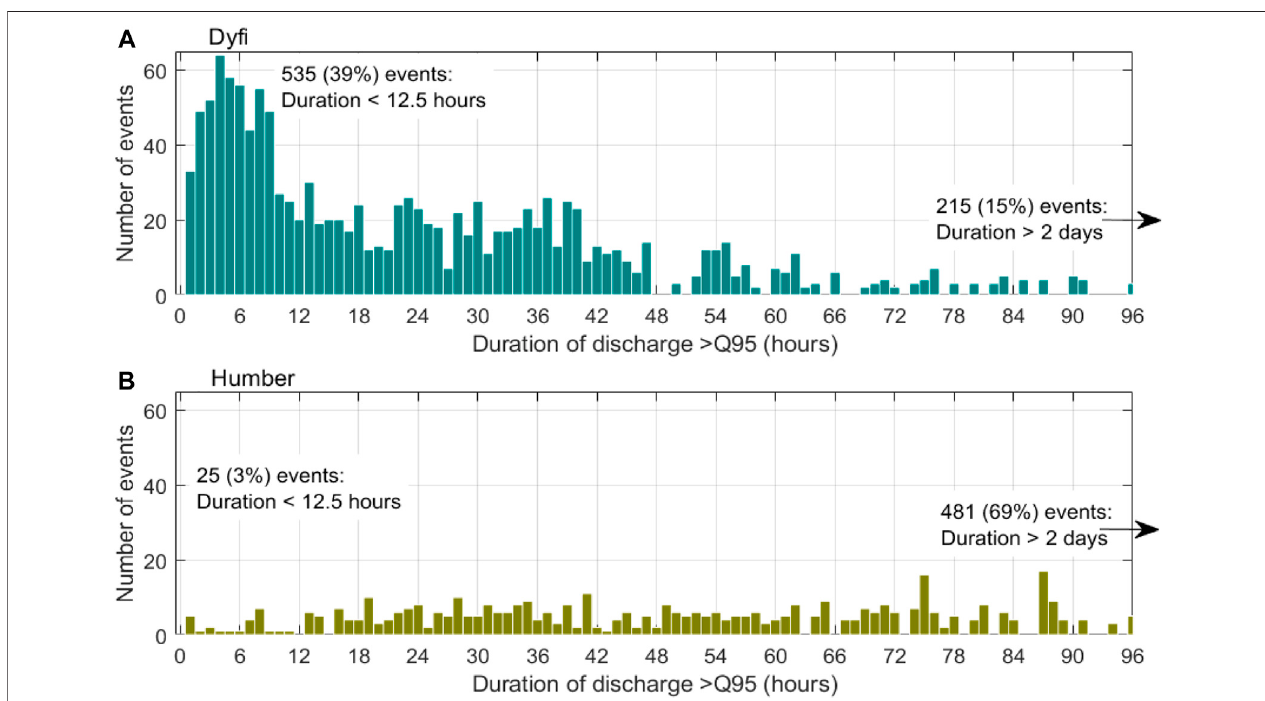
FIGURE 4 | Histograms showing fl uvial event durations (T Q , in hours) that the fl ow exceeds the 95 th percentile fl ow, for (A) the Dy fi (Q95 (cid:1) 80 m 3 /s) and (B) the Humber (Q95 (cid:1) 570 m 3 /s).